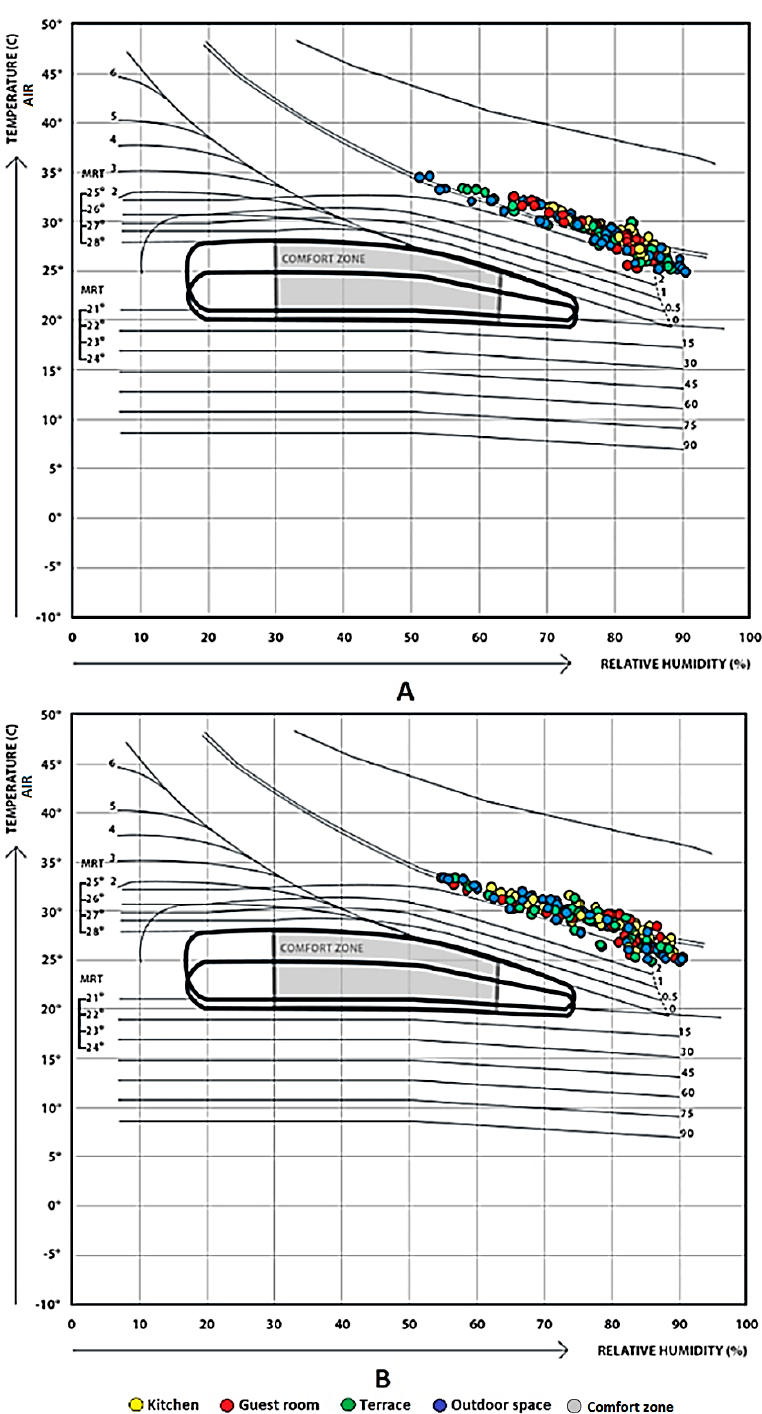
Figure 12. The Olgyay diagrams for exposed brick houses ( A ) and wooden houses ( B ) on beaches. Variables of thermal comfort in exposed stone houses and wooden houses in the mountains are seen to approach a comfort zone, while thermal variables in exposed brick houses and wooden houses on beaches are far from the comfort zone. The inhabitants of mountain homes attempt to perform behaviors influencing the thermal conditions of a room, one of which is warming their body using a fireplace. In contrast, the inhabitants of houses on beaches do not perform behaviors influencing the thermal conditions. How- ever, their behaviors are connected to their activities and clothing.